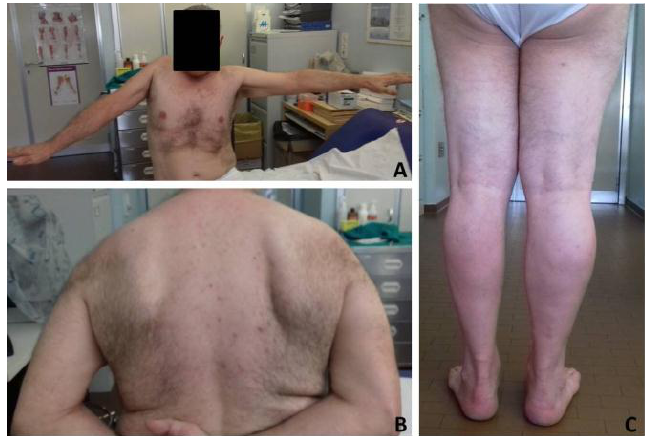
Figure 1. Clinical evaluation after four years from onset. ( A ) Patient presented with upper limb proximal hypotrophy and right upper limb impaired abduction. ( B , C ) Unchanged right winged scapula and left lower limb hypotrophy were also observed.